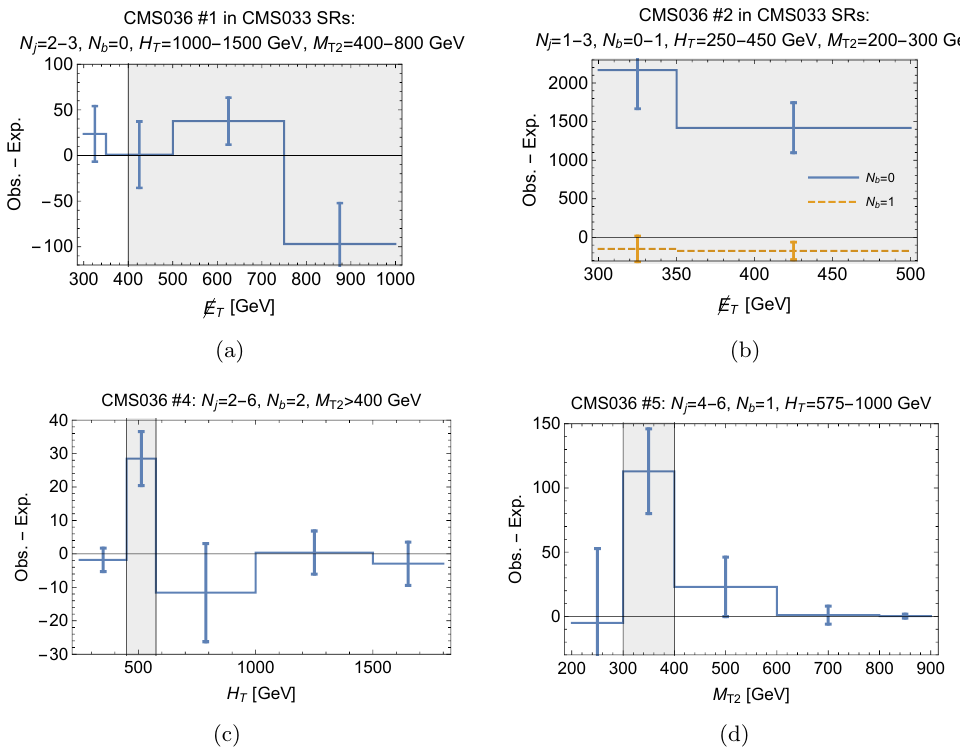
Figure 13 . Kinematic distributions which suggest various CMS036 excesses (see table 1) are unlikely to be new physics. The residuals (observed minus expected) are shown in blue, (with error bars denoting the error). In each plot, the shaded grey region denotes the region with an observed excess. See text for